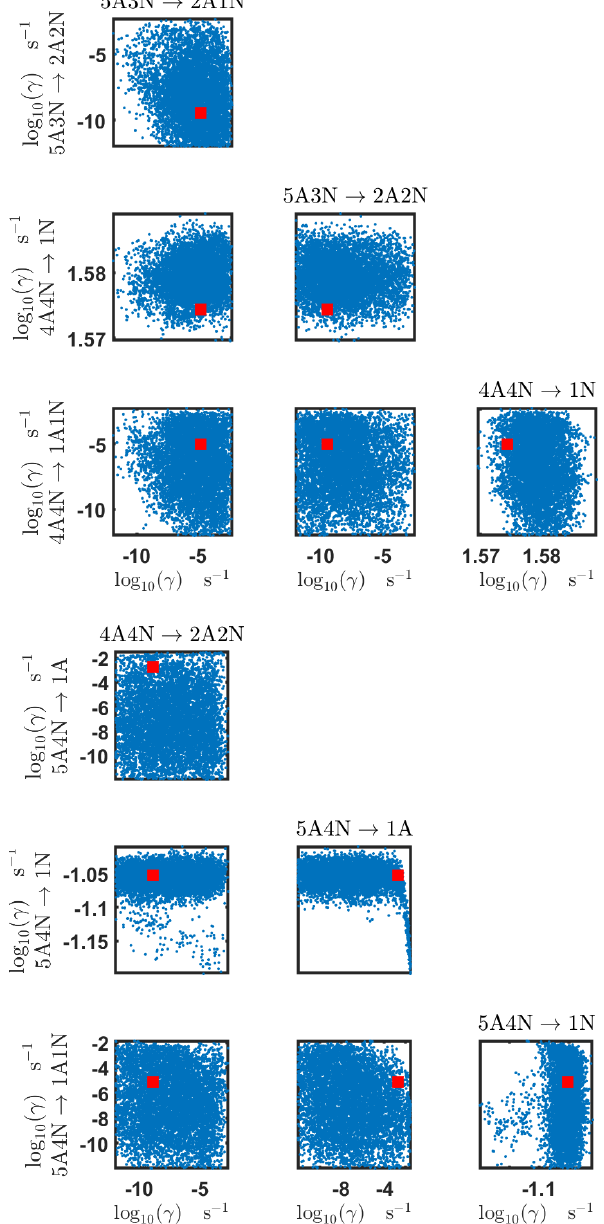
Figure B5. Pairwise marginal posterior distributions (for parame- ter indexes ranging from 17 to 24) of the base 10 logarithm of the evaporation rates (units given in s − 1 ) determined from steady-state cluster concentration measurements at the temperature 278K. Red rectangles denote the baseline values from Olenius et al. (2013b) used to generate the synthetic data. The notation xAyN corresponds to a cluster with x sulfuric acid and y ammonia molecules.